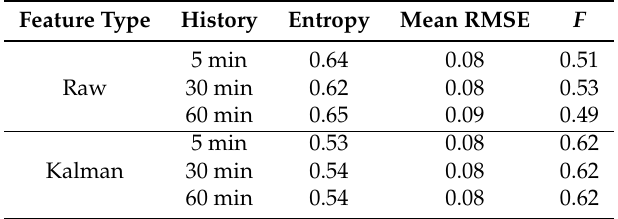
Table 3. Performance details with clustered segments and 4000 sample size.